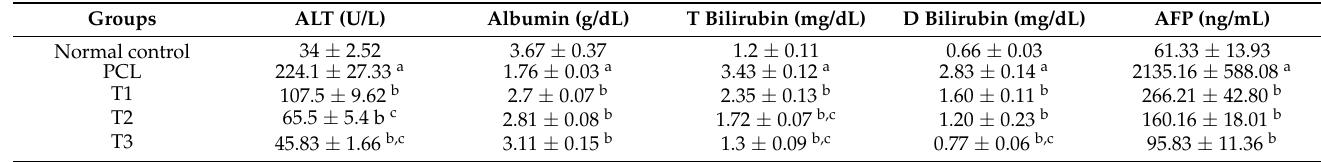
Table 1. Liver functions and alfa fetoprotein (AFP)among the investigated groups of rats.